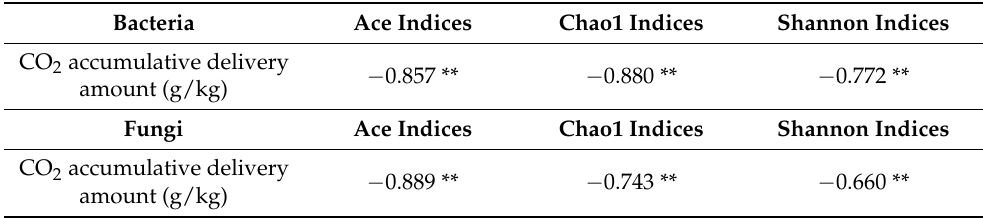
Table 6. Correlation analysis between cumulative CO 2 release and soil microbial diversity after catechol addition. Bacteria Ace Indices Chao1 Indices Shannon Indices CO 2 accumulative delivery amount (g/kg) Ace Indices Shannon Indices